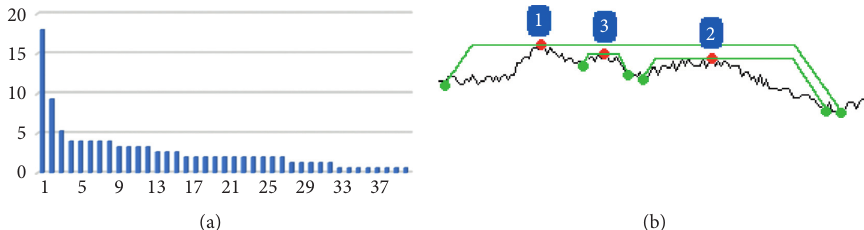
Figure 13: (a) Sorted prominences of Road5 data, where the ratio of the third (the prominence of the last detected peak) to the fourth (the greatest prominence of the noise) is 131%. (b) The detected peak points (each marked by its prominence ordinal number) and the supporting hills.